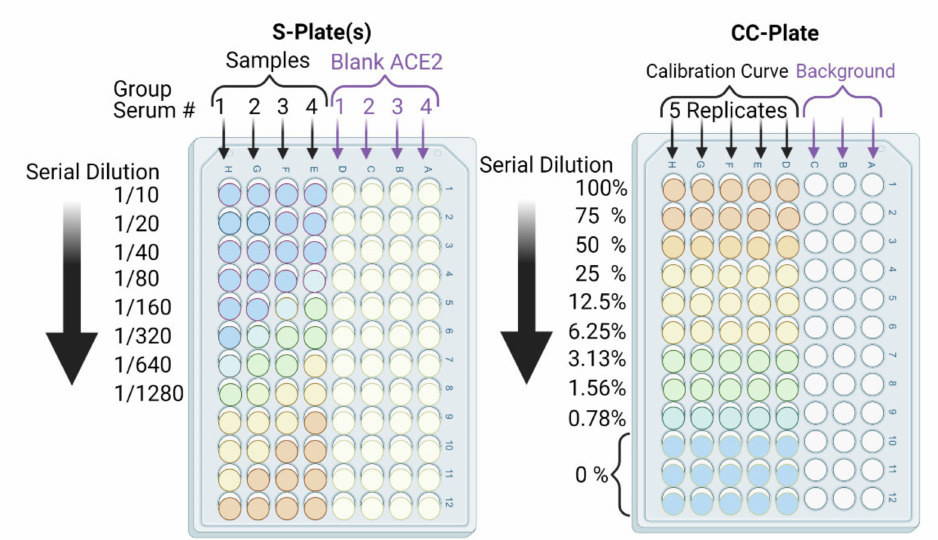
Figure 5. Schematic depicting cELISA plates: calibration curve (CC)-plate and sample (S)-plate arrangement, orientation, and associated dilutions. The lowest calibration curve value (0.78%) corresponds to our assay’s detection limit. Accurate quantitation starts from ≥ 6.25%. S-plate sample rows have RBD, BSA block, serum, ACE2, and 2 ry Ab. S-plate blank ACE2 rows have RBD, BSA block, the same serum, and 2 ry Ab. CC-plate calibration curve rows have RBD (different amounts), BSA block, ACE2, and 2 ry Ab. CC-plate background rows have BSA block, ACE2, and 2 ry Ab. To check non-specific serum interactions (with ACE2 and/or 2 ry Abs) and efficient washing (of ACE2 and 2 ry Abs), background and blank ACE2 rows are